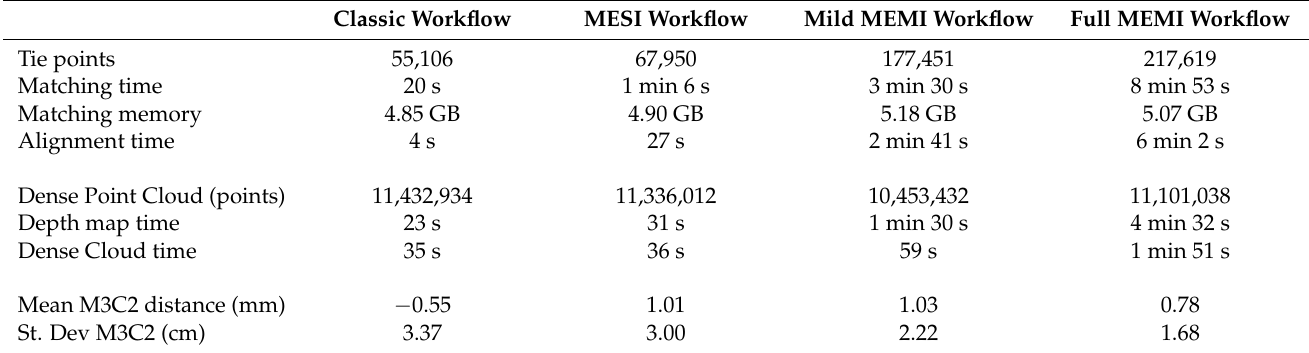
Table 1. Main parameters of the point clouds and M3C2 results obtained in May 2020 test.